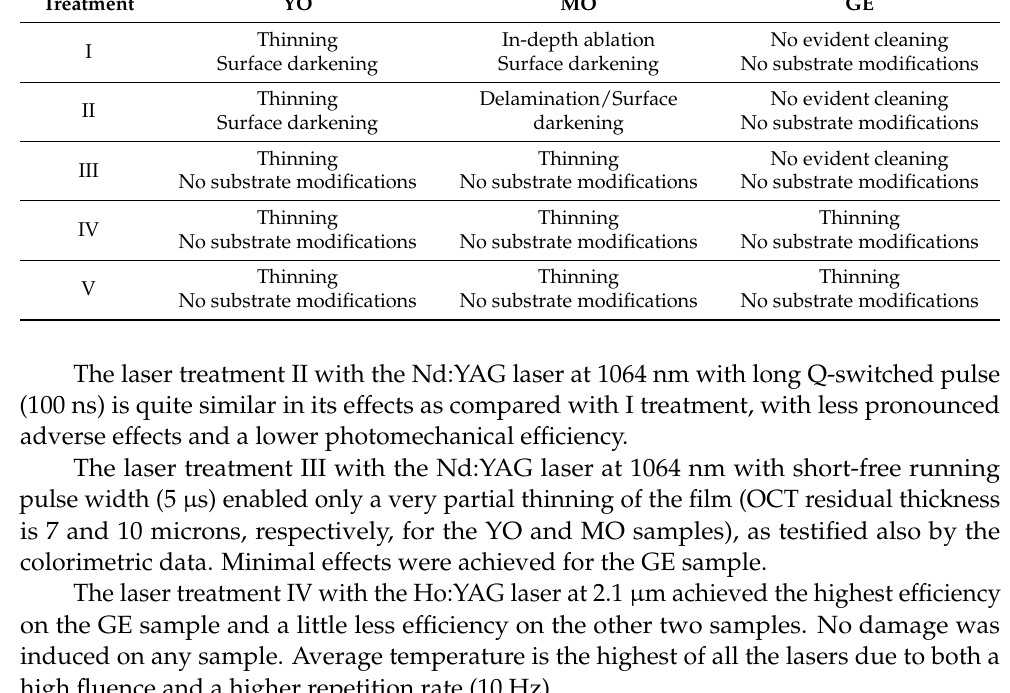
Table 8. Overall observations of the effects of the I–V laser treatments (t 2 − t 0 ).